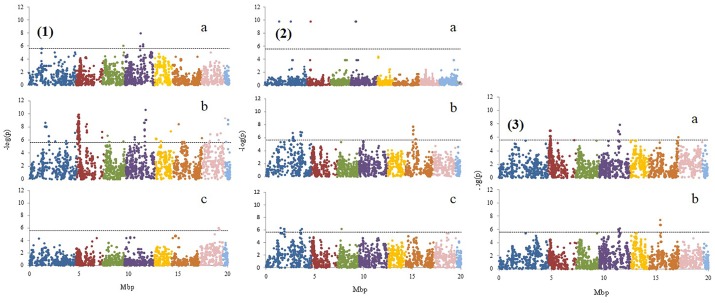
Genome scan showing –log (p) value for marker associations (K-model) with 1: (a) blooming date, (b) harvest date, and (c) ripening index; 2: (a) anthocyanins, (b) flavonoids, and (c) relative antioxidant capacity; 3: (a) sorbitol and (b) total sugars. The different colors represent the different linkage groups from 1 to 8.